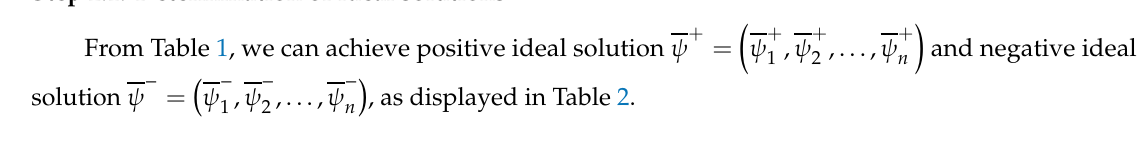
Table 2. Positive ideal solution and negative ideal solution.